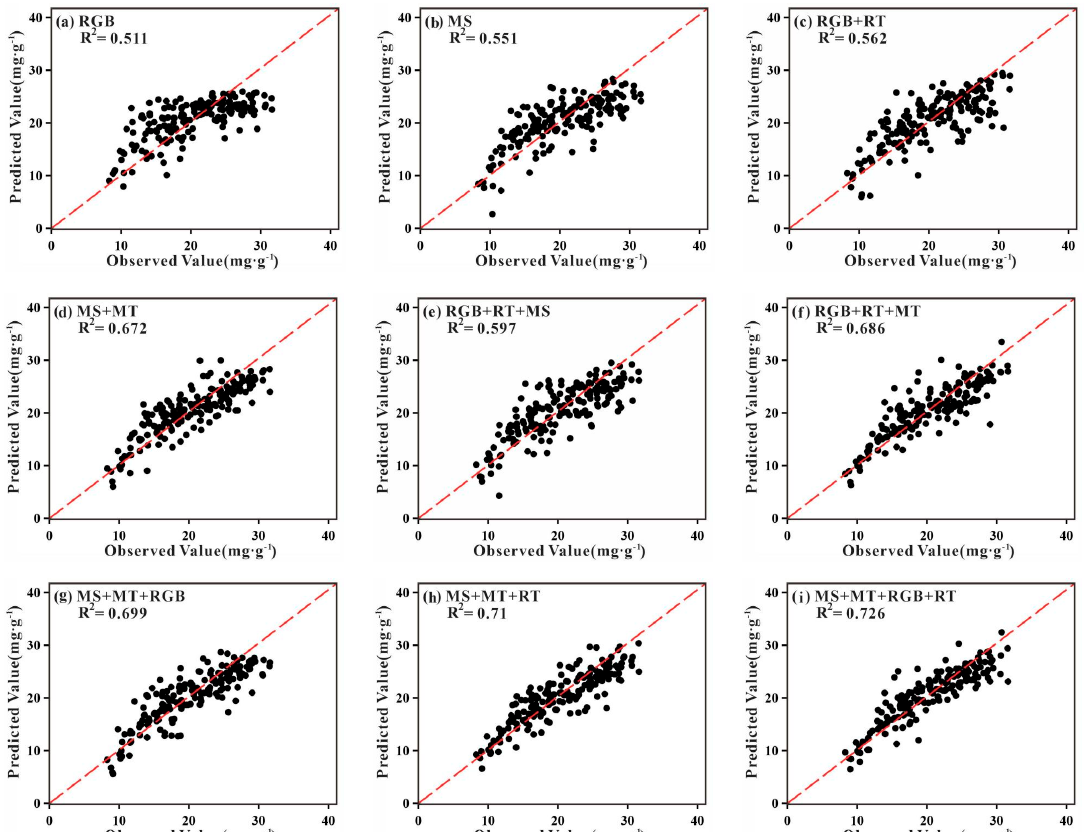
Table 6. t-test under di ff erent nitrogen treatments. Figure 7. Observed and predicted values of the best TNC prediction model constructed based on each of the seven input features. RT RGB Texture Features, MS Multi-spectral spectral features, MT Multi-spectral texture features.